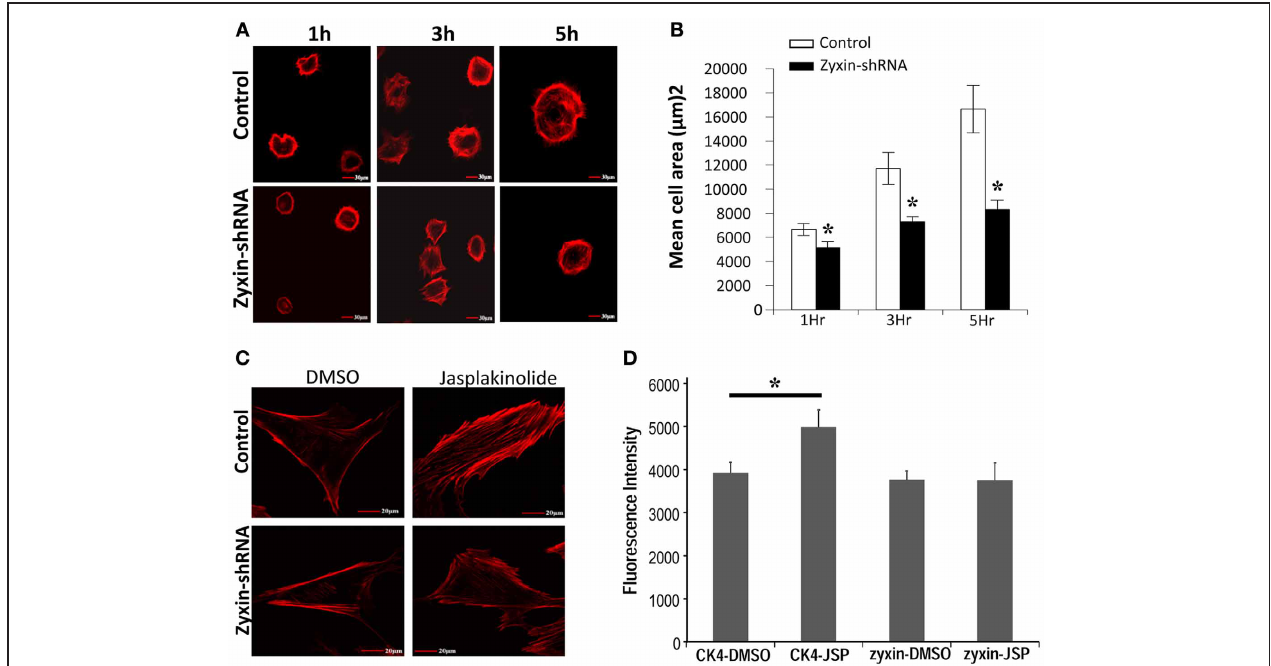
FIGURE 6 | Zyxin silencing inhibited VSMC actin cytoskeleton reorganization. (A) silencing of zyxin inhibited VSMC spreading. Non-silencing control or zyxin-shRNA transfected VSMCs were suspended with serum-free culture medium and plated on 50 μ g/ml fibronectin-coated dishes for 1, 3, and 5h under standard culture conditions. Cells were then fixed and stained with Alexa 568 conjugated-Phalloidin. Images were taken with a 40x oil objective. Scale Bars, 30 μ m. (B) Bar graphs represent mean of cell spreading areas calculated using NIH Image J (* p < 0 . 05 vs. control). Error bars represent error of the mean. Results are representative of five independent experiments. (C) Silencing of zyxin inhibited